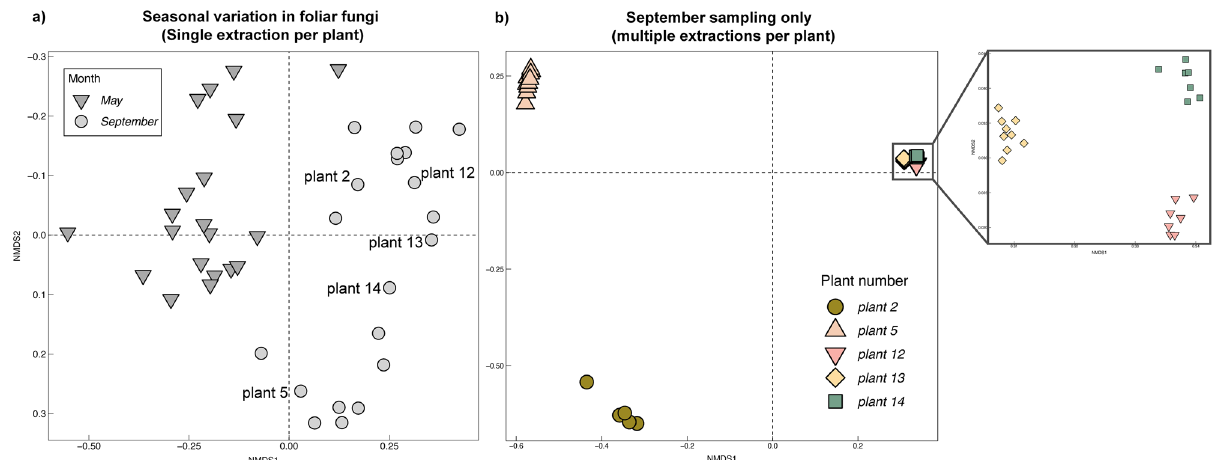
Figure 6. Nonmetric multi-dimensional scaling based on Bray–Curtis distances of foliar fungal endophytes in milkweed plants. Panel ( a ) represents the seasonal variation in foliar endophytic fungi when analyzing just one extraction rep per plant (leaf discs). Panel ( b ) represents the variation among plants when analyzing multiple extractions from each plant in September. The zoomed in panel highlights the less pronounced, but significant clustering among individual plants 2, 5, 12, 13 and